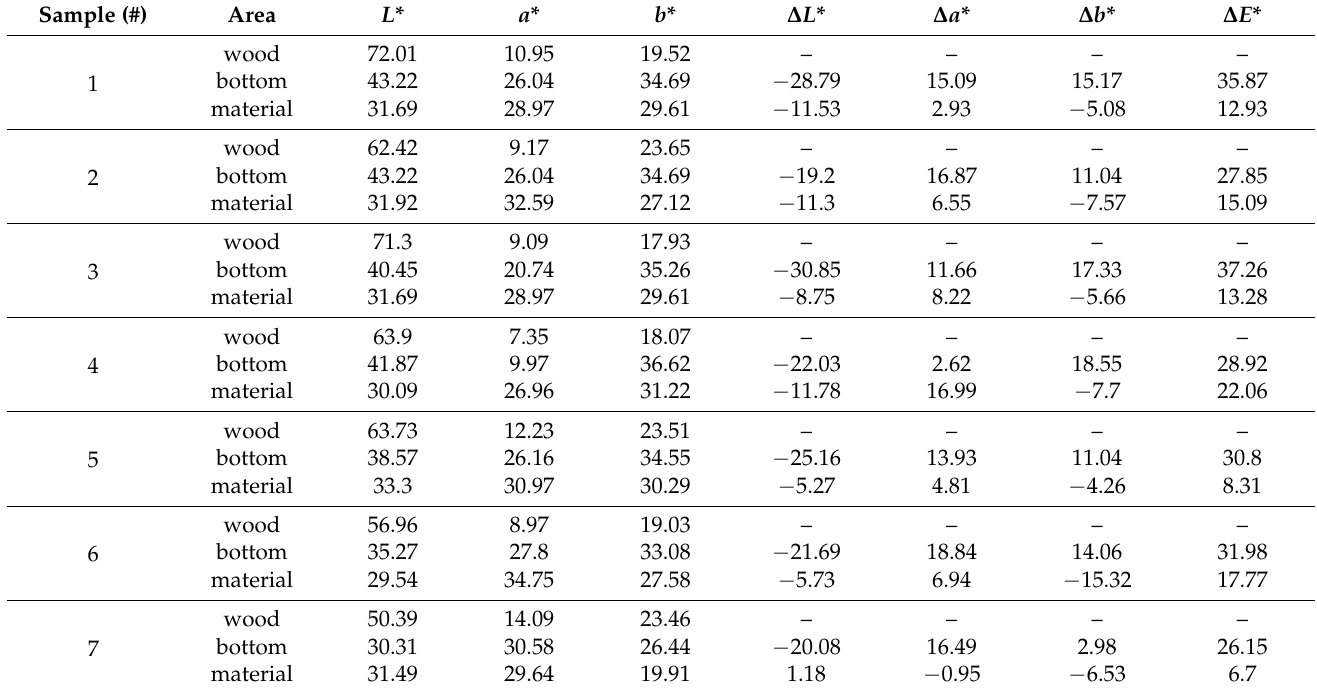
Table 4. Chromatic parameters for modified poplar by the colorant of European and American